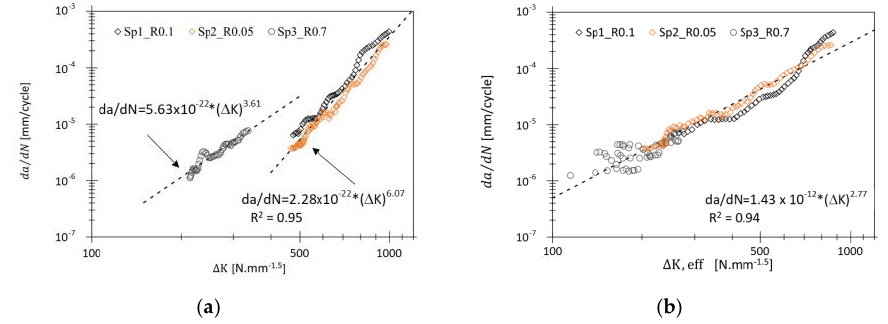
Figure 16. Fatigue crack growth data for the CT specimens: ( a ) use of applied stress intensity factors; ( b ) use of effective stress intensity factors.